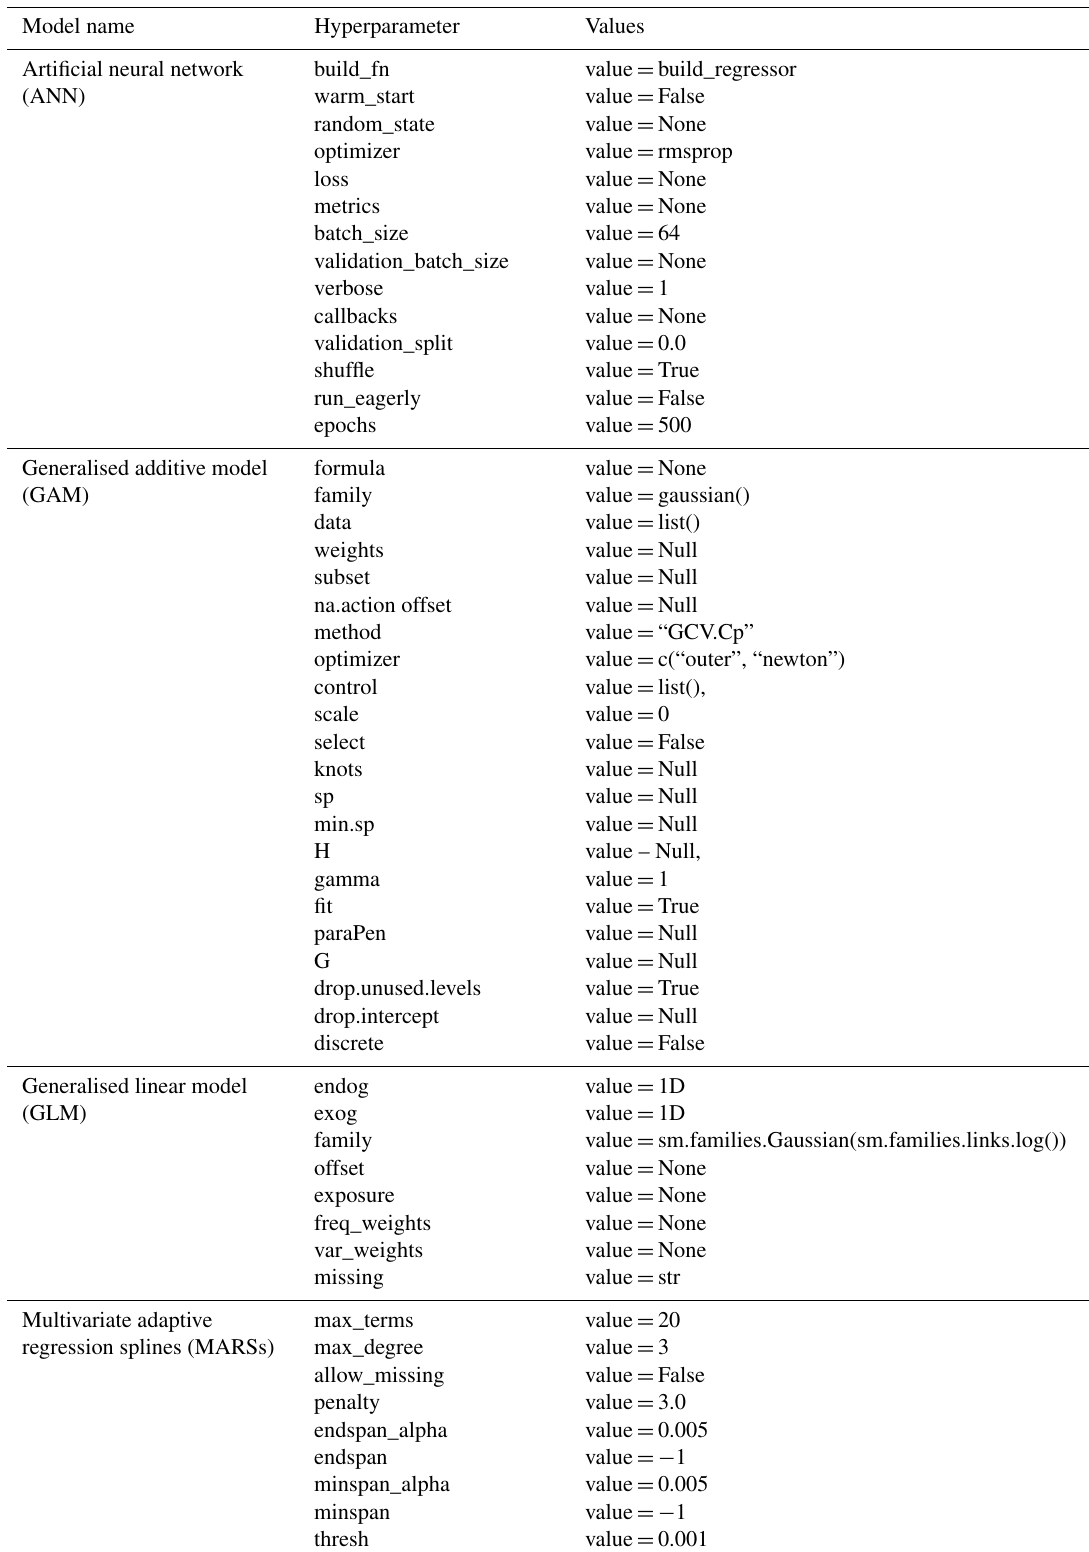
Table 2. The information on hyperparameters used for estimating model